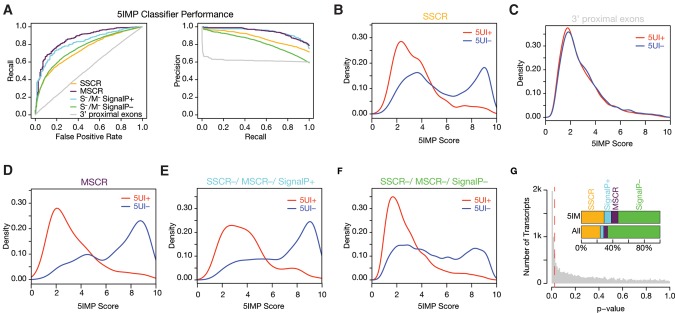
Predicting 5UI status accurately using only early coding sequences. (A) As judged by area under the receiver operating characteristic curve (AUROC) and AUPRC, the 5IM classifier performed well for several different transcript classes. (B) The distribution of 5IMP scores reveals clear separation of 5UI+ and 5UI− transcripts for SSCR-containing transcripts, where each SSCR-containing transcript was scored using a classifier that did not use that transcript in training (Materials and Methods). (C) Coding sequence features that are predictive of 5′ proximal intron presence are restricted to the early coding region. This was supported by identical 5IM classifier score distributions with respect to 5UI presence for negative control sequences, each derived from a single randomly chosen “window” downstream from the third exon from one of the evaluated transcripts. (D) MSCR transcripts exhibited a major difference in 5IMP scores based on their 5UI status even though no MSCR transcripts were used in training the classifier. (E) Transcripts predicted to contain signal peptides (SignalP+) had a 5IMP score distribution similar to that of SSCR-containing transcripts. (F) After eliminating SSCR, MSCR, and SignalP+ transcripts, the remaining S–/MSCR– SignalP– transcripts were still significantly enriched for high 5IM classifier scores among 5UI− transcripts. (G) The control set of randomly chosen sequences downstream from the third exon from each transcript was used to calculate an empirical cumulative null distribution of 5IMP scores. Using this function, we determined the P-value corresponding to the 5IMP score for all transcripts. The red dashed line indicates the P-value corresponding to 5% false discovery rate. The inset depicts the distribution of various classes of mRNAs among the input set and 5IM transcripts.